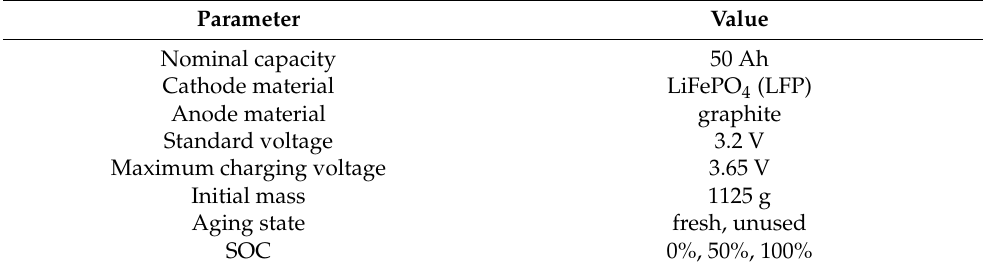
Table 1. Basic battery information